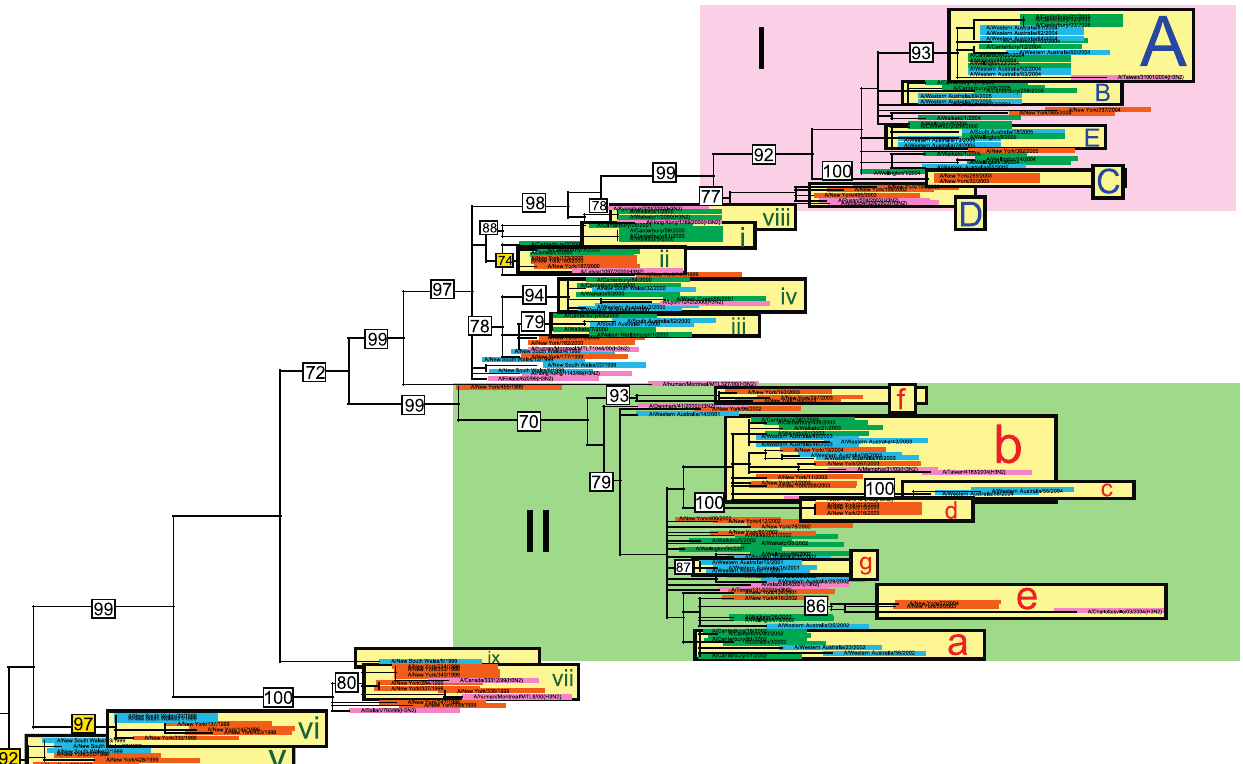
Figure 2. Phylogenetic Relationships of the NA Gene of A/H3N2 Influenza Viruses Sampled from New York State ( n ¼ 52), New Zealand ( n ¼ 51), Australia ( n ¼ 45), and Globally ( n ¼ 22) from 1998 to 2005, Estimated Using ML Viral isolates from New York state are highlighted in orange, isolates from New Zealand in green, isolates from Australia in blue, and global isolates in pink. Light yellow rectangles identify viral clades, with numbers in white boxes giving bootstrap values for key nodes ( . 70%). To clarify reassortment events, capital letters in blue refer to clades that appear in section I of the tree (denoted in pink) on the phylogeny of the concatenated six non-surface glycoproteins; lowercase letters in red refer to clades contained within section II (denoted in light green); and lowercase roman numerals in dark green refer to clades outside sections I and II. Bootstrap values highlighted in yellow identify nodes that define a cross-hemisphere migration event. The tree is rooted by isolate A/New York/327/1999 from the 1998–1999 season (i.e., the earliest sampled isolate), and all horizontal branch lengths are drawn to a scale of nucleotide substitutions per site.